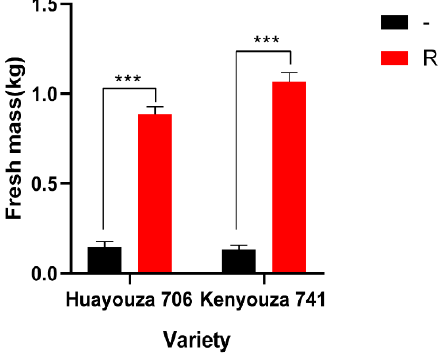
Figure 6. Evaluation of agro-morphological characters of the improved Kenyouza 741R and Huay- ouza 706R. -: Huayouza 706/Kenyouza 741; R: Huayouza 706R/Kenyouza 741R. *** Significance: p < 0.01. Table 2. Fresh mass of the aerial parts of Kenyouza 741R and Huayouza 706R plants from replicates I to III. Fresh Mass of Aerial Parts of 20 Plants (kg) Variety